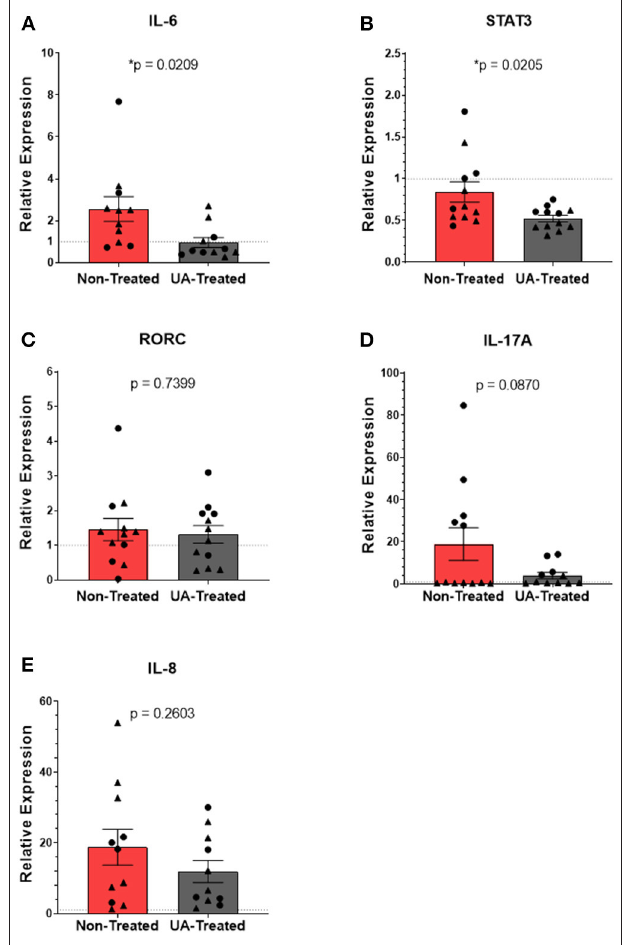
FIGURE 4 | Prophylactic UA treatment modulates inflammatory IL-17A signaling in the lungs following MH infection. Samples of lung tissue were collected at necropsy and stored in RNAlater solution for qPCR analysis of (A) IL-6, (B) STAT3, (C) RORC, (D) IL-17A, and (E) IL-8 mRNA expression; individual animal data from F2019 has been represented as a circle (•), while S2020 animal data has been represented as a triangle ( N ). The relative mRNA expression in pneumonic lung tissue from non-treated and UA-treated animals was compared to healthy lung tissue from control animals (F2019 group) for both studies. The average relative expression (RE) ± the SEM for each treatment group across both studies is depicted in (A–E) . Outliers were identified using the ROUT method (Prism v9.1.0), and the data were analyzed using a standardized unpaired t -test (* p < 0.05). (A) Non-treated n = 11, UA-treated n = 11; (B) non-treated n = 12, UA-treated n = 12; (C) non-treated n = 12, UA-treated n = 12; (D) non-treated n = 12, UA-treated